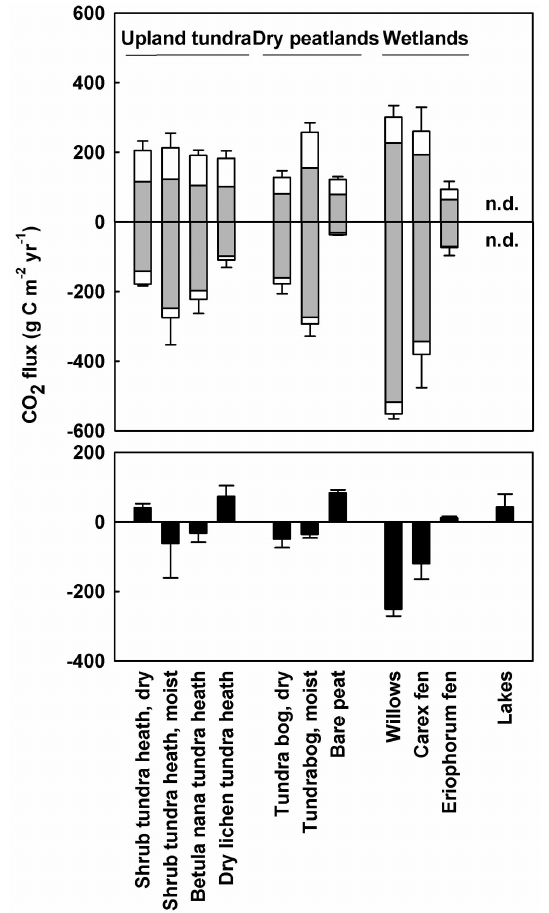
Fig. 5. The annual CO 2 balance (6 October 2007–5 Octo- ber 2008) at different microsites: ER and GP (top), NEE (bottom) (mean ± SD; n = 3). The ER and GP are divided into growing sea- son and non-growing season fluxes. Positive values mean C loss from the ecosystem and negative values C uptake.